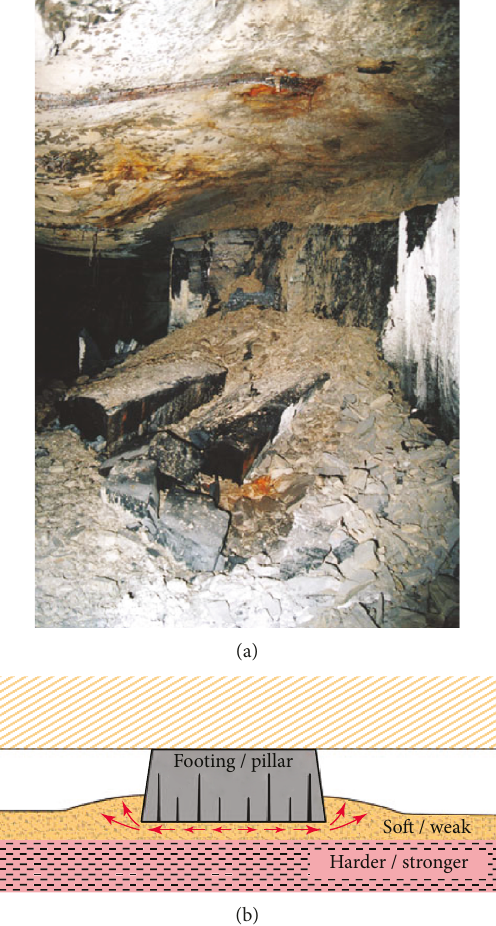
Figure 4: (a) Blocky rib spall along cleat planes due to weak interface lateral tension [24] and (b) pillar slabbing due to squeezing of the soft fl oor [24].